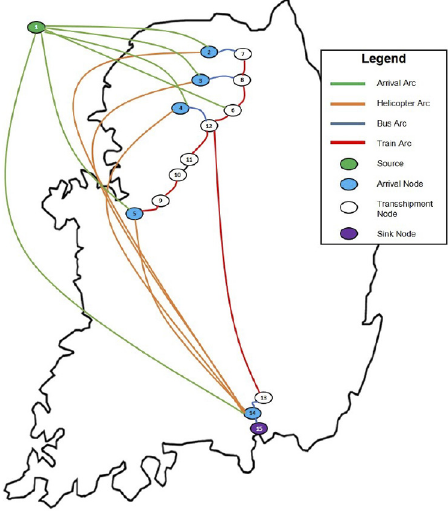
Figure 4. (color online) Network structure of South Korea